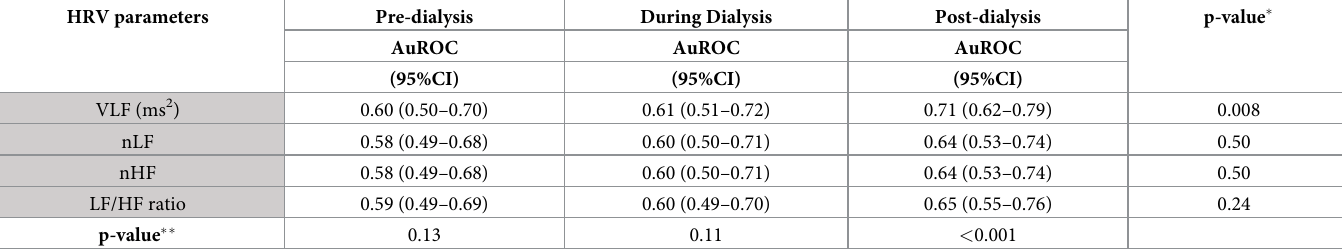
Table 4. Area under receiver operating characteristic curve (AuROC) for survival according to VLF, nLF and LF/HF ratio and for death according to nHF at differ- ent time points. HRV parameters